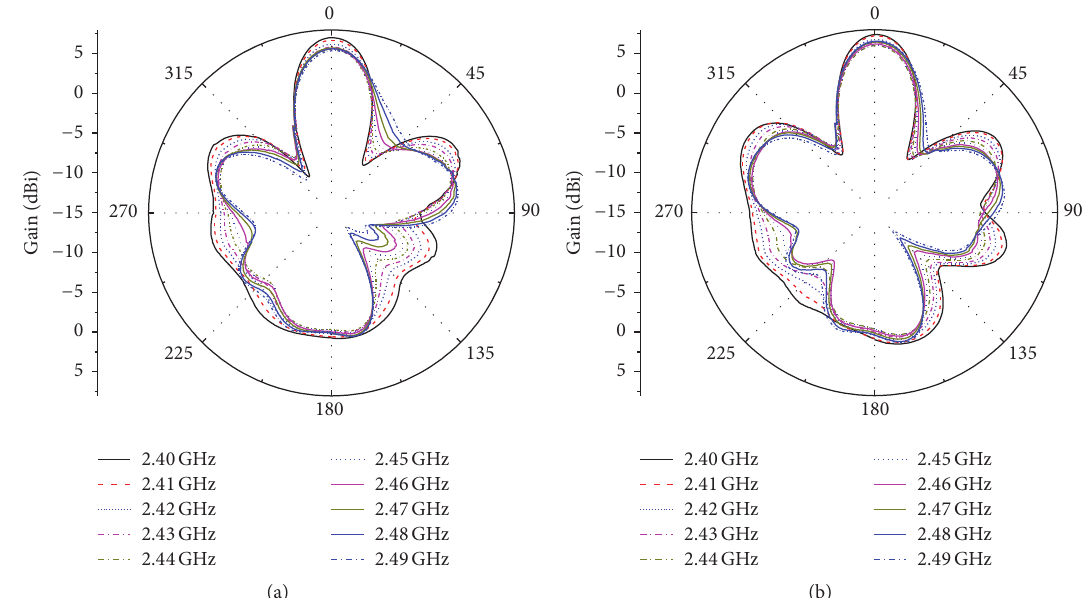
Figure 19: High-gain mode radiation patterns of WiFi band for the examination of beam bandwidth. (a) Without constraint. (b) Constrained by mean square error condition.